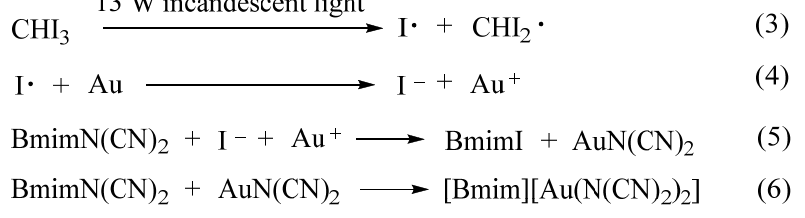
Scheme 2. Mechanism of dissolution of gold by CHI 3 /BmimN(CN) 2 . Figure 8. Reaction mechanism diagram. Figure 8. Reaction mechanism diagram. Figure 8. Reaction mechanism